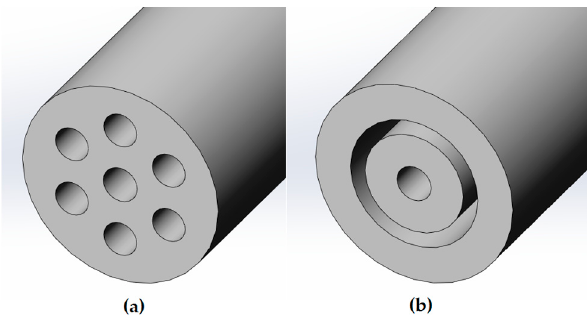
Figure 4. Cross section of the IC 1.1 tip ( a ) and the assumption defined for the generation of the axisymmetrical computational domain ( b ).